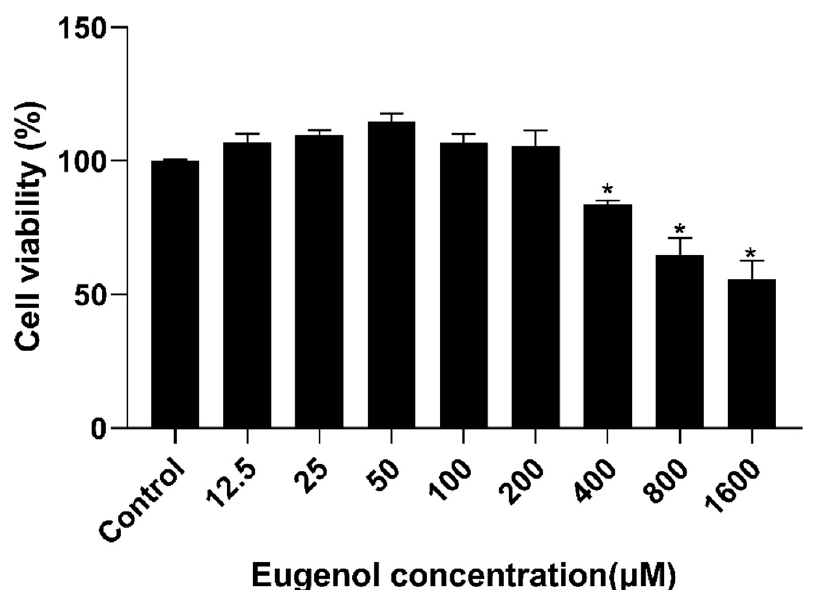
Figure 7. Effect of eugenol on IPEC-J2 cells’ viability. IPEC-J2 cells were treated with eugenol for 36 h ( n = 6). Data are expressed as the mean ± SEM. * p < 0.05.